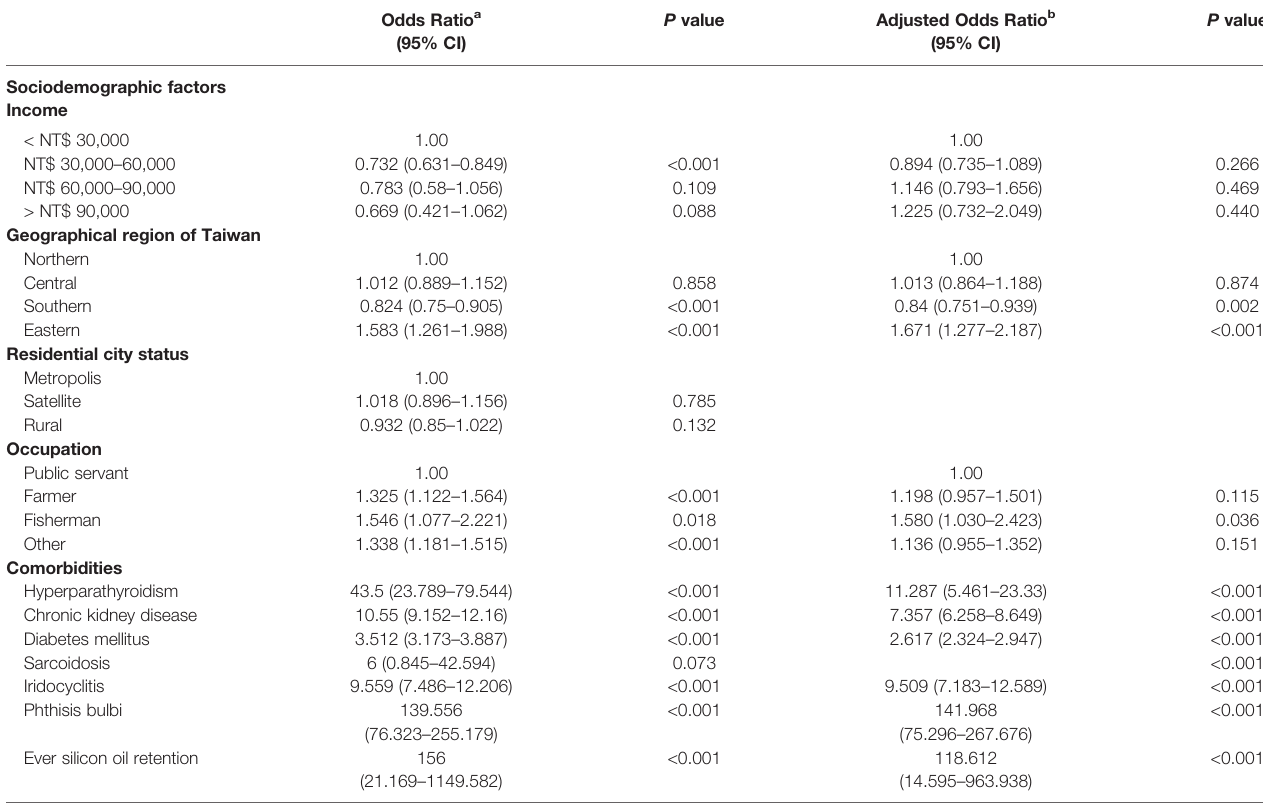
TABLE 2 | Odds ratios and adjusted odds ratios for various sociodemographic factors and comorbidities associated with band keratopathy. Odds Ratio a P value Adjusted Odds Ratio b P value (95% CI) (95%